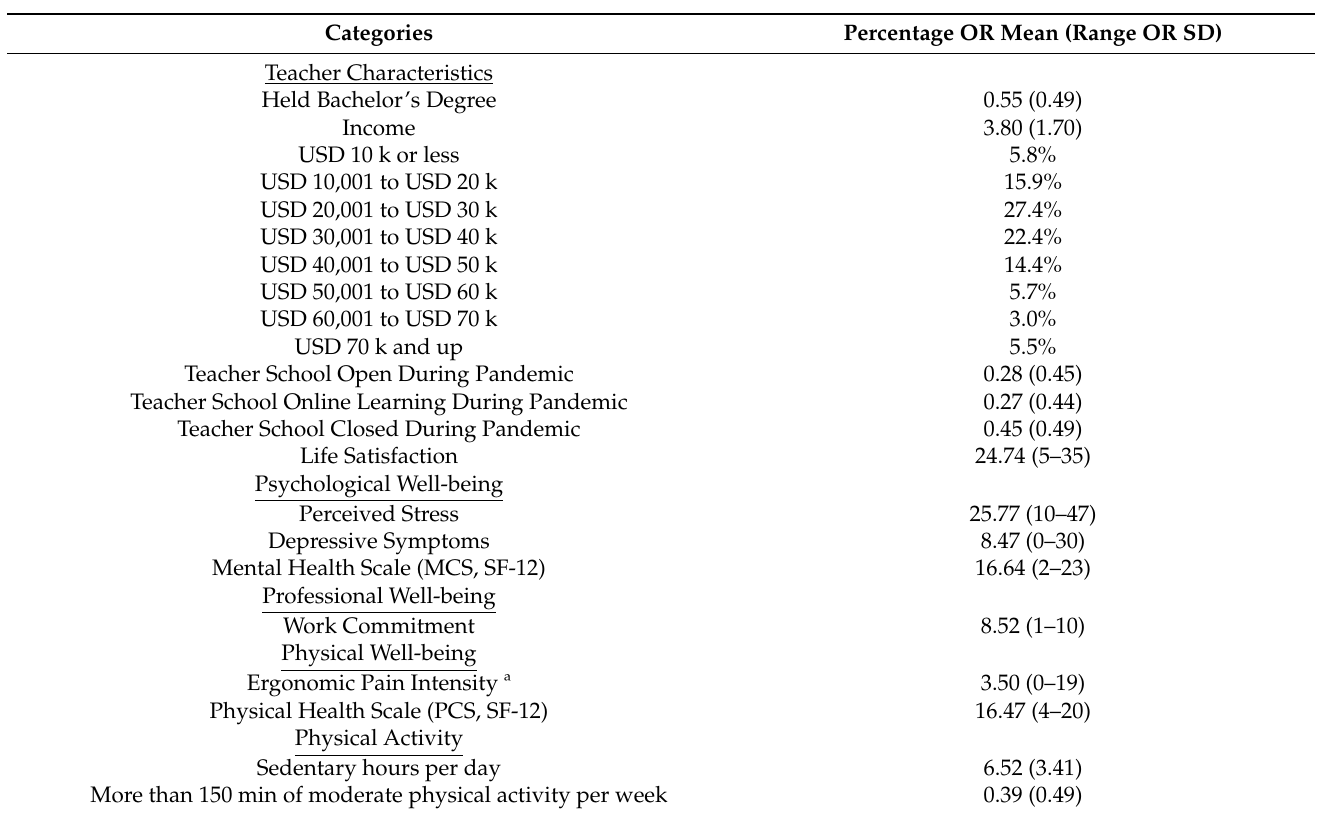
Table 2. Descriptive Statistics for Study Variables ( n = 1234).